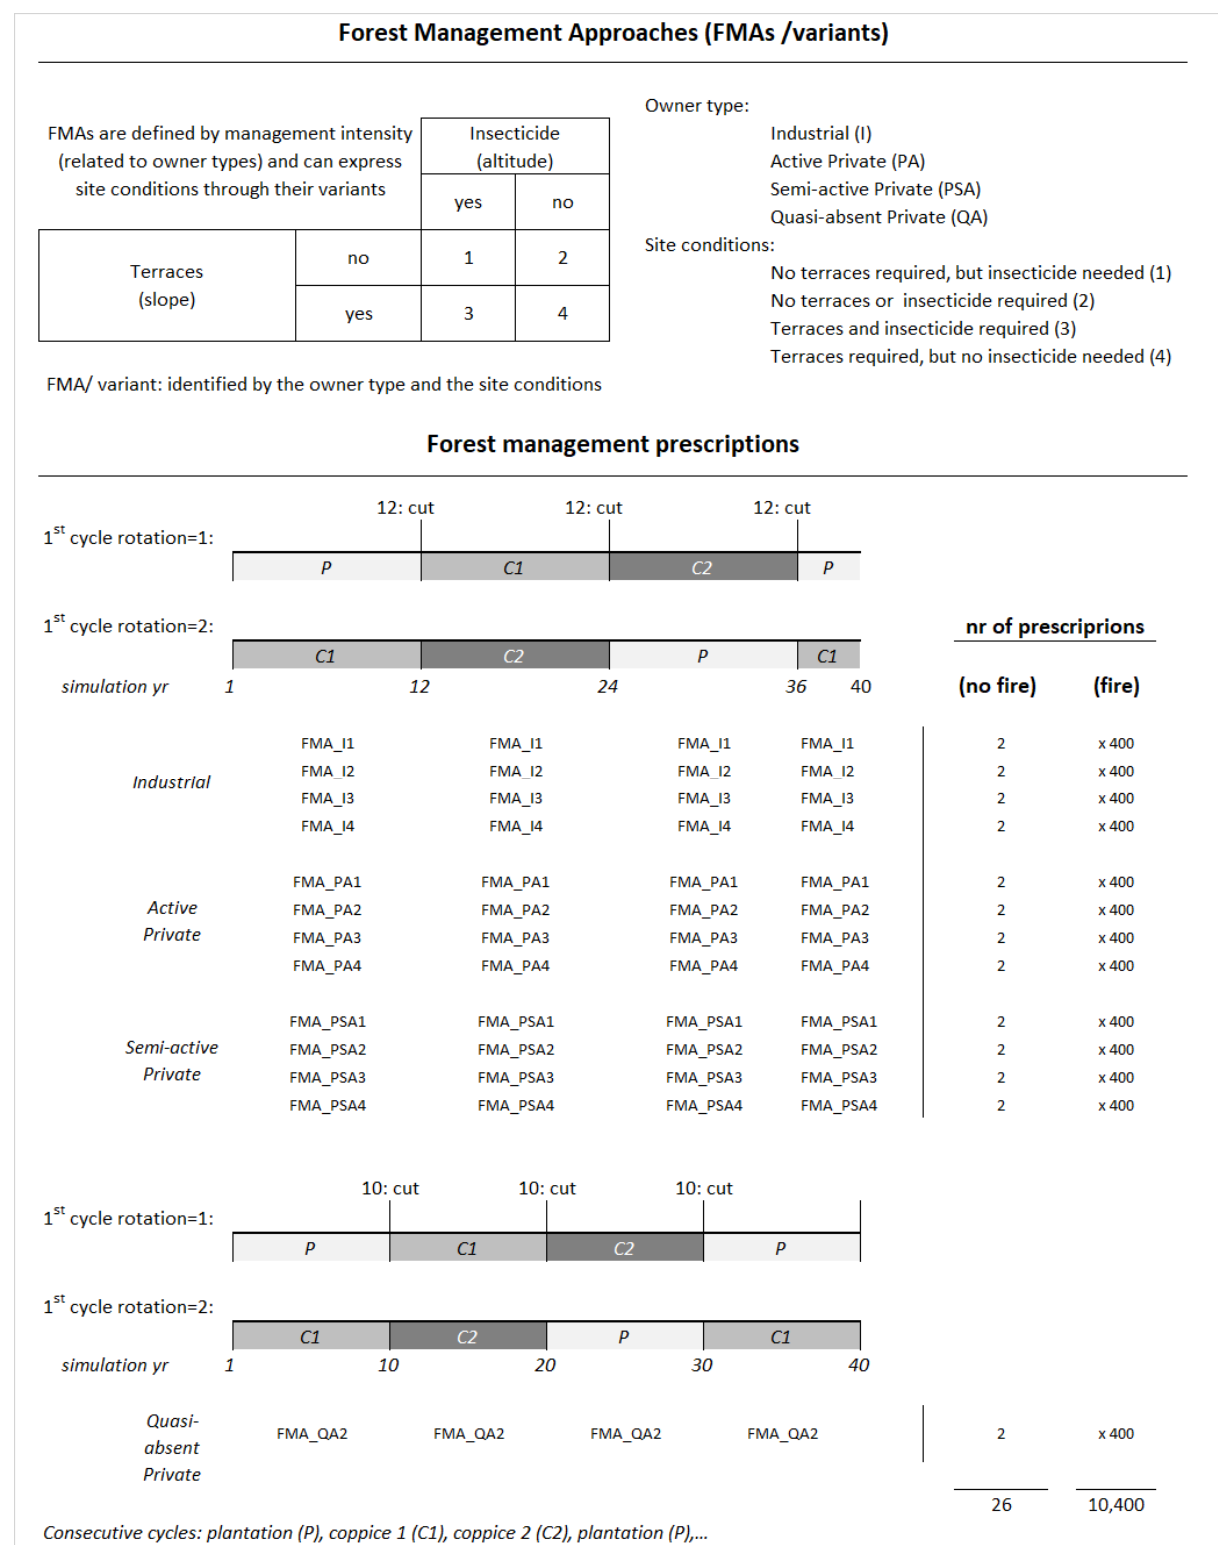
Figure A2. Description of the FMAs and management prescriptions considered for the simulations with fire (having the randomness of fire occurrence illustrated in Figure A1 in each set of 400 prescriptions) and without fire.